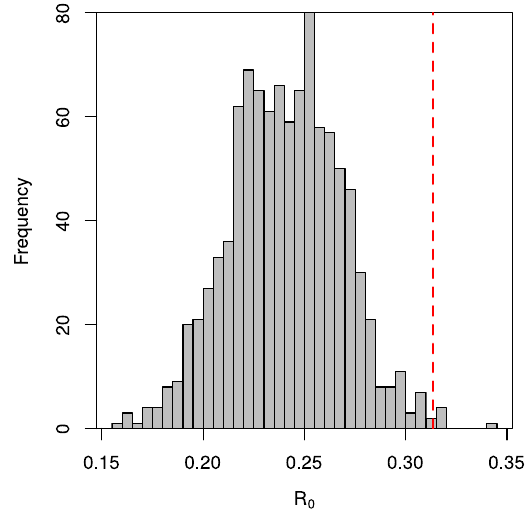
Fig. 4 The results of the Monte Carlo permutation test. The grey bars show the null distribution of R 0 from the 739 permutations that converged, whereas the red dashed line shows the observed R 0 (0.31) calculated from the twinstim model.